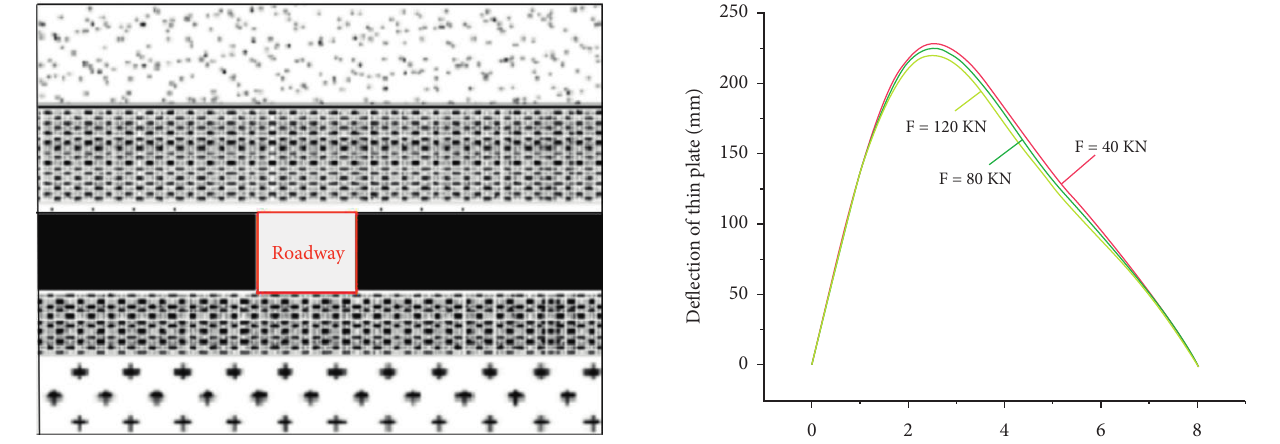
Figure 1: Schematic diagram of rock distribution of the large-span roadway.